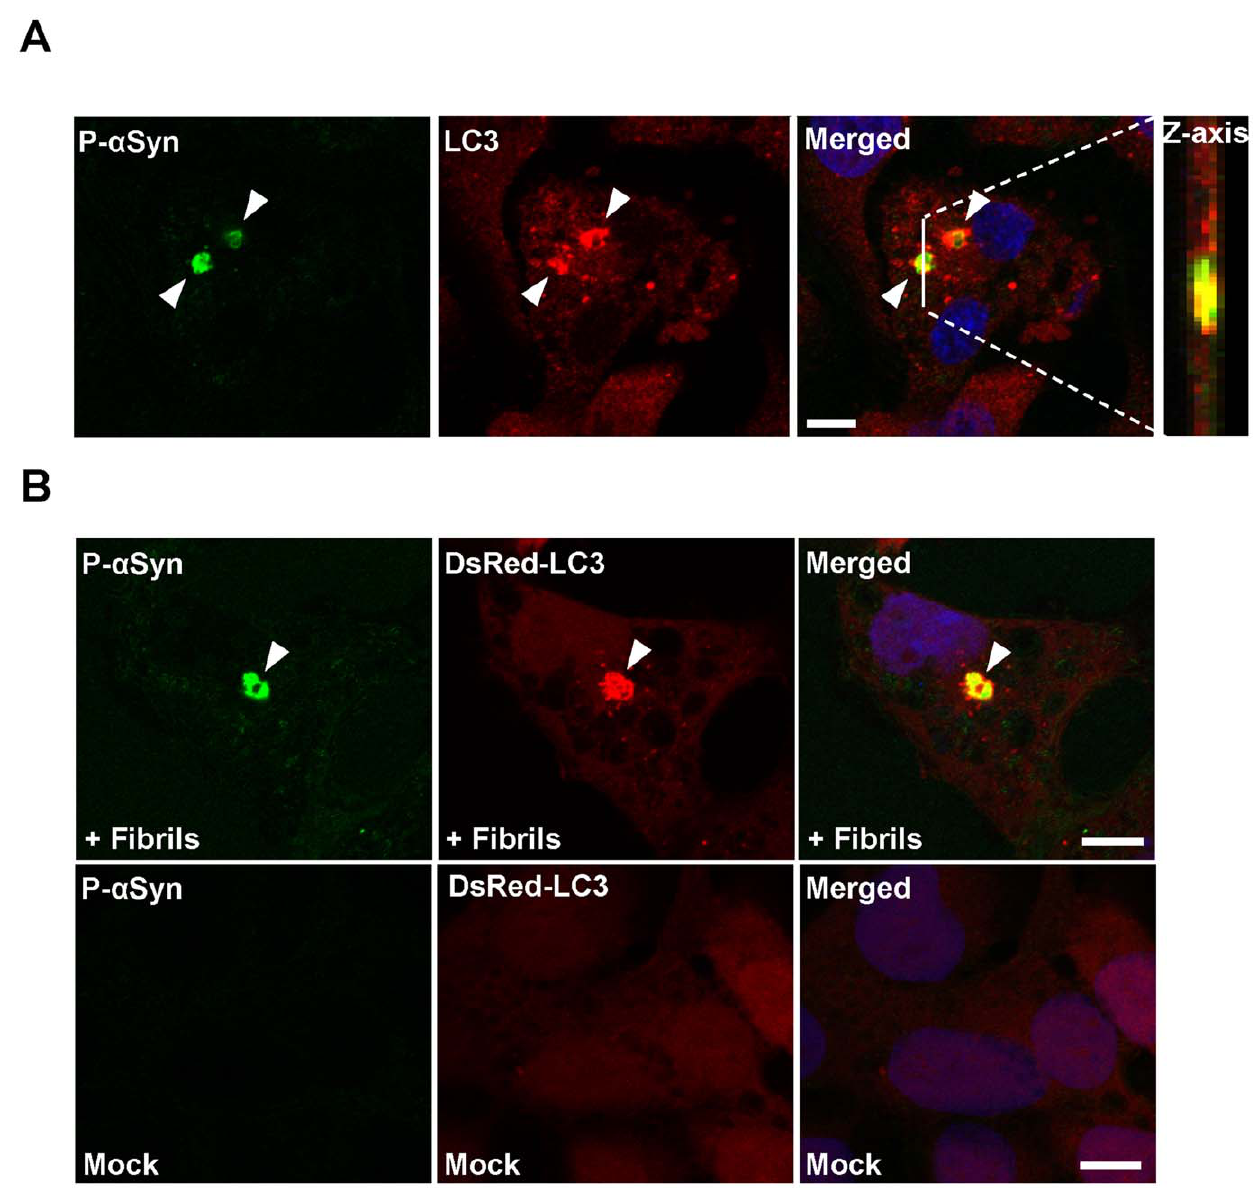
Figure 2. Autophagic clearance of a -synuclein inclusions. ( A ) Autophagic clearance of a -synuclein inclusions was verified by immunocytochemical analysis with anti-phosphorylated a -synuclein (P- a Syn) and anti-LC3 (LC3) antibodies. Confocal images reconstructed in the z-axis along the white lines are shown in the right panel (Z-axis). Blue, DAPI. Scale bar, 10 m m. Phosphorylated a -synuclein-positive inclusions were sequestrated into LC3-positive autophagosomes. ( B ) Similarly, this sequestration was confirmed in HEK293 cells stably expressing DsRed-LC3. The upper and lower panels show a -synuclein fibrils-and mock-introduced cells, respectively. Blue, DAPI. Scale bar, 10 m m.